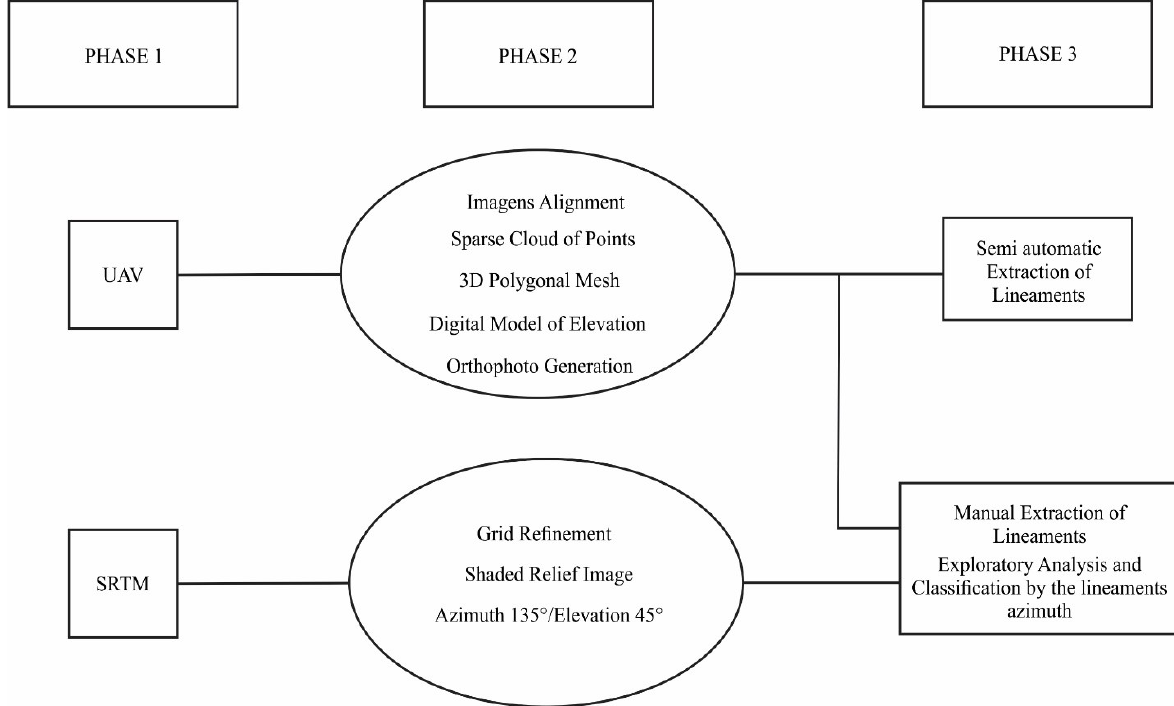
Figure 1. Flowchart of the methodology